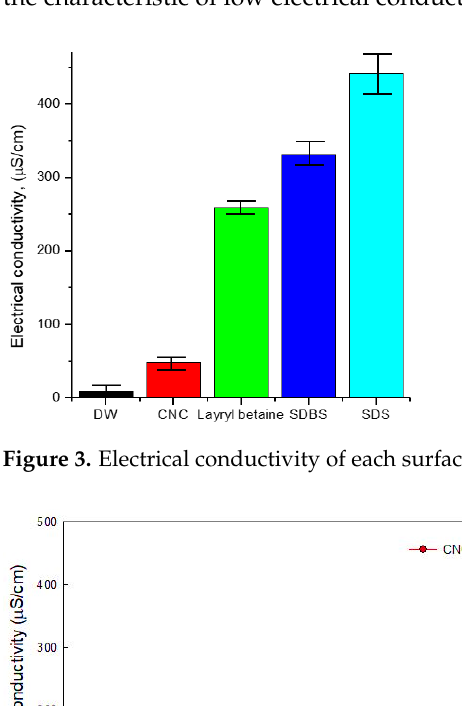
Figure 2 . TEM image of cellulose nanocrystal (( A ): 0.2 μm, ( B ): 50 nm, ( C ): 10 nm).